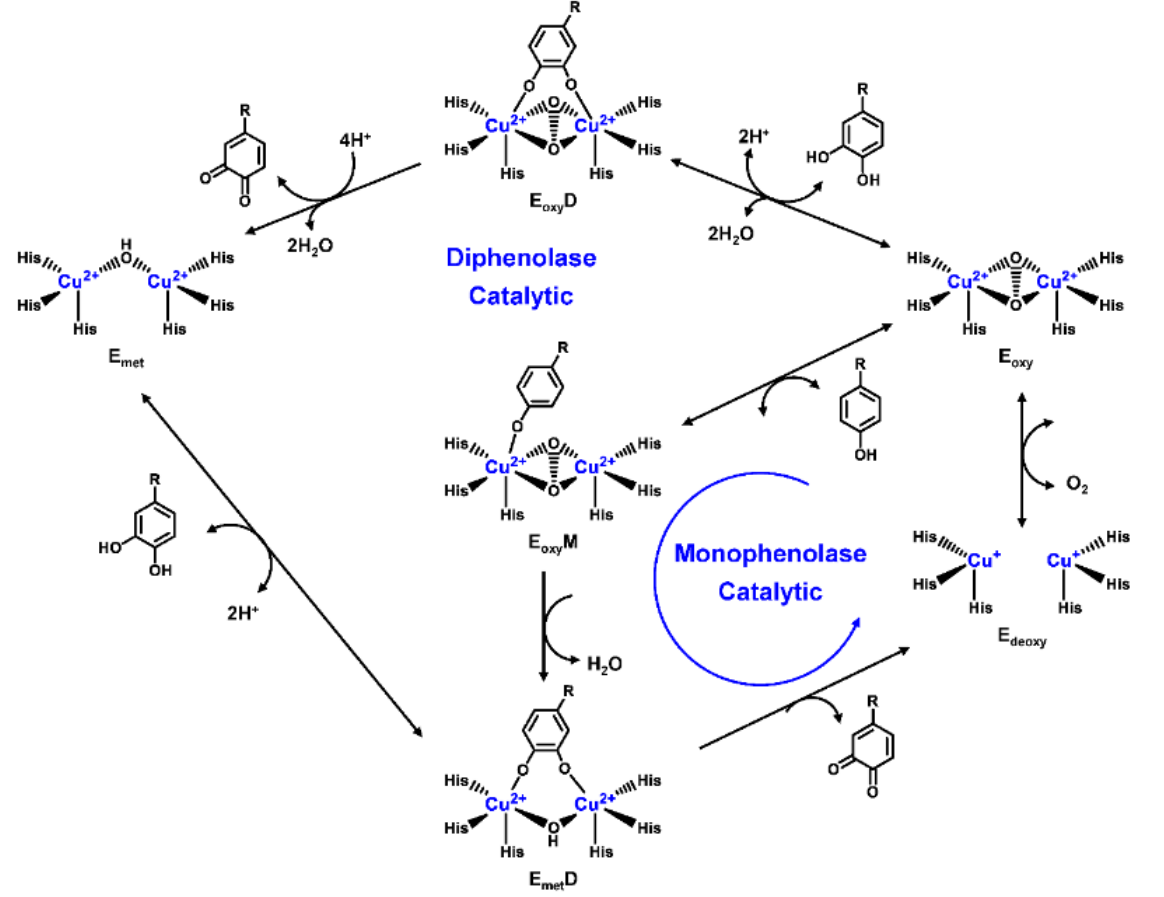
Figure 4. Catalytic cycle of TYR.